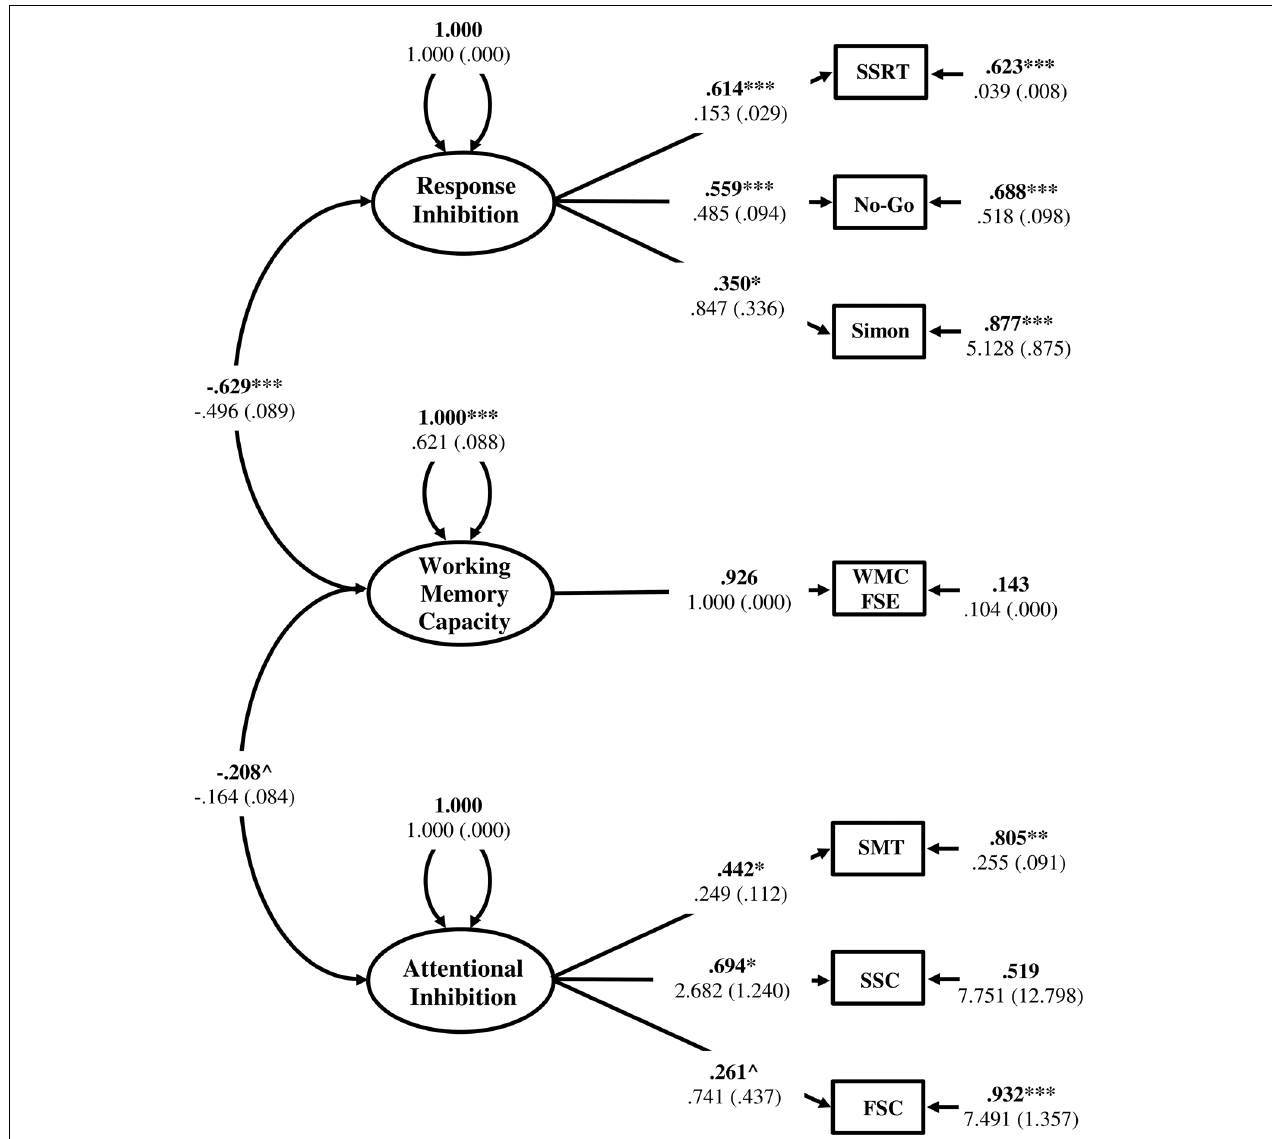
FIGURE 7 | Measurement model of inhibitory control with three, empirically distinct factors corresponding to WMC, Response Inhibition, and Attentional Inhibition. WMC FSE, Working Memory Capacity Factor Scores Estimates; SSRT, Stop-Signal Reaction Time; No-Go, Commission errors on Go/No-Go task; Simon, Simon SR-conflict; SMT, Shape matching SS-conflict; SSC, Stroop SS-conflict; FSC, Flanker SS-conflict. Fully standardized estimates are in bold type face. Numbers below are unstandardized parameter estimates with bootstrapped standard errors in brackets. ∗∗∗ p < 0.001, ∗∗ p < 0.01, ∗ p < 0.05, ˆ p < 0.1.